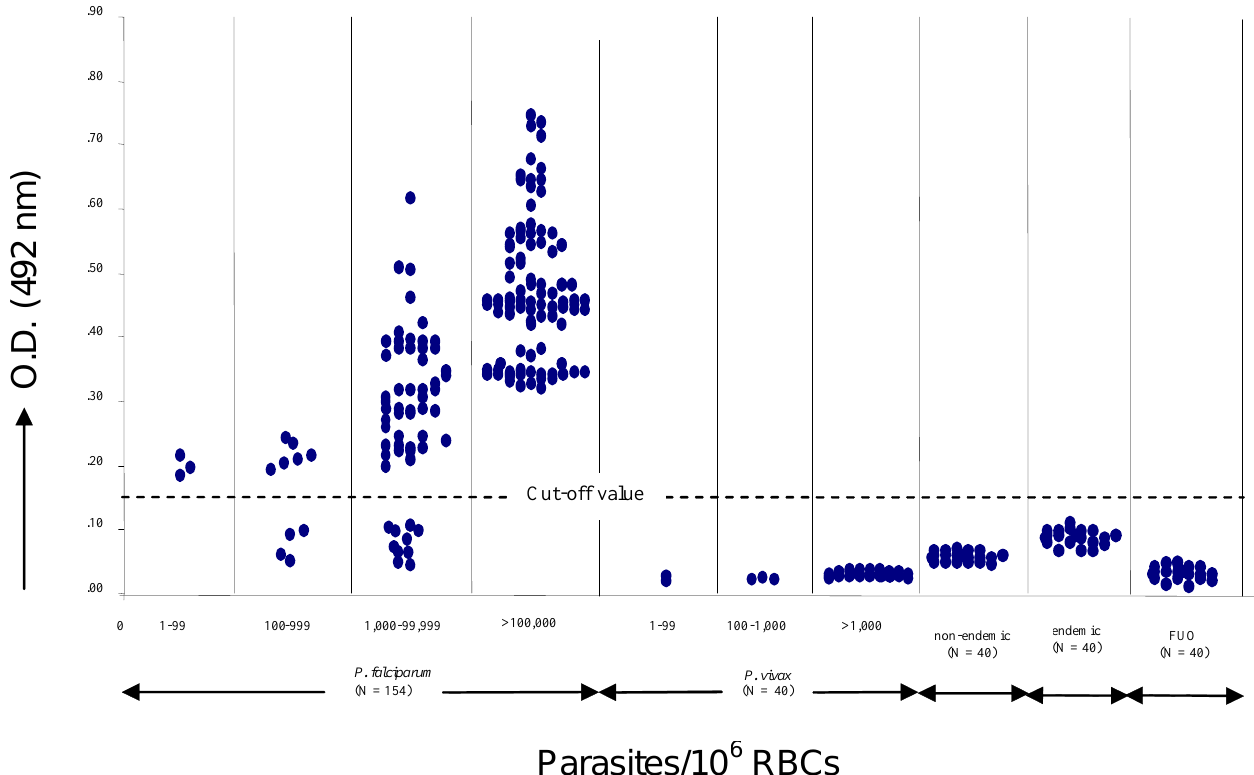
Fig.1 : Scatter diagram of O.D. values from the MAb-PAb based indirect ELISA for the detection of 154 P.falciparum samples. 16 out of 154 samples were negative as the O.D. of these samples were below the established cut-off value of 0.151. Forty healthy individuals were from malaria endemic and 40 from non-endemic healthy individuals and 40 P.vivax infected individuals showing all negative with the assay system. Likewise, 40 samples of fever of unknown origin were also negative as the O.D. values of all samples were below the established cut-off